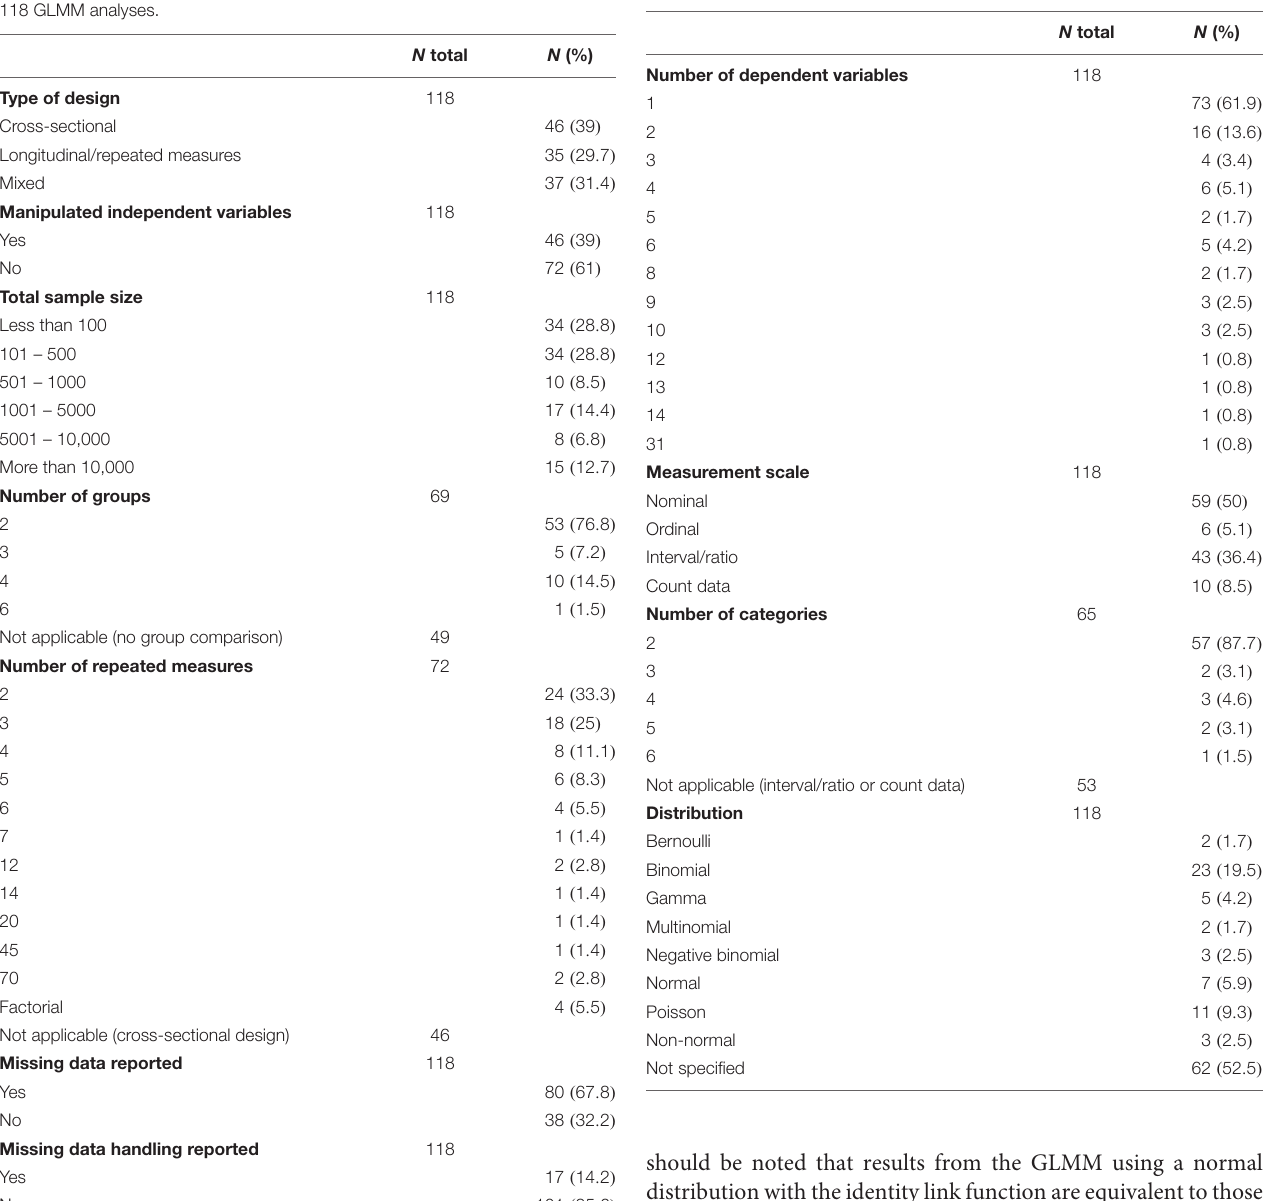
TABLE 2 | Characteristics of dependent variables in the 118 GLMM